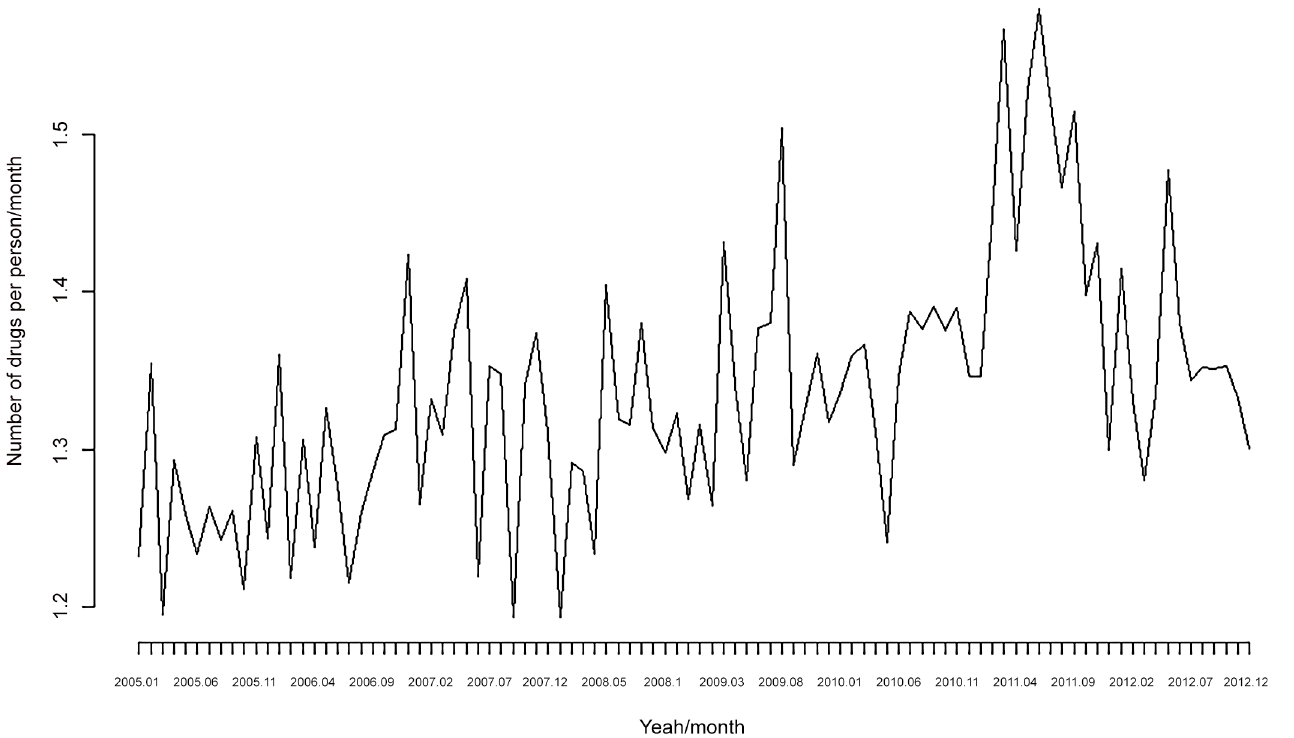
Fig 1. Consumption of psychotropic drugs. Number of drugs per person/month. Monthly data for the period 2005 – 2012.